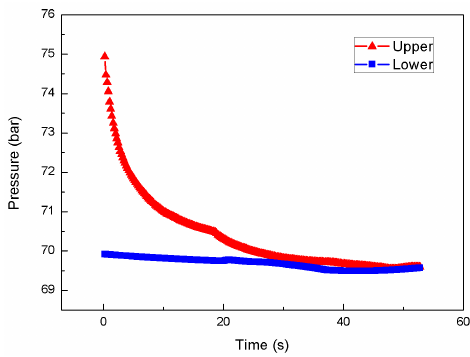
Figure 10. Temporal variation of differential pressure between chambers during the throttling process at 75/70 bar.